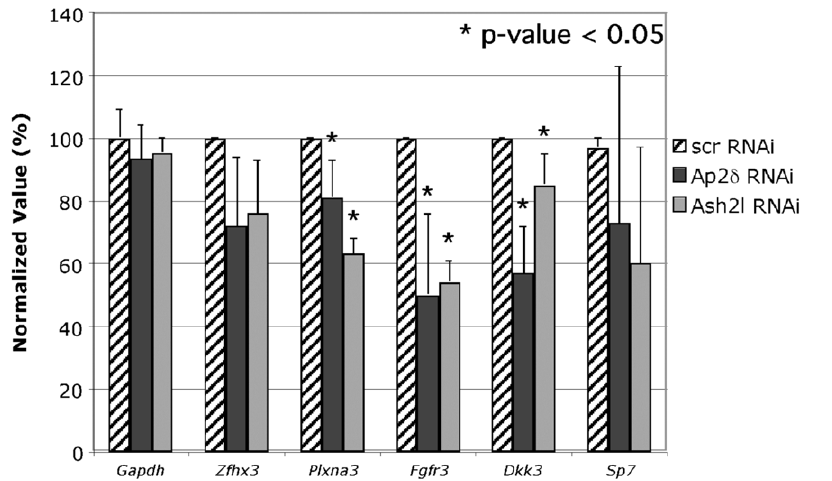
Figure 3. Ap2 d and Ash2l regulate Plxna3,Fgfr3andDkk3 expression in Neuro2a cells. Plxna3 , Fgfr3 and Dkk3 are downregulated when Ap2 d and Ash2l are downregulated. Total RNA was extracted 72 hours post-transfection from Neuro2a cells treated with Tcfap2d - or Ash2l -specific siRNA or scrambled control. Gapdh , Zfhx3, Plxna3, Fgfr3, Dkk3 and Sp7 transcript levels were quantified by real-time PCR. Normalized values were calculated as percentages of transcript levels detected in cells treated with the scrambled control. Significant differences are as indicated with * (p # .05). doi:10.1371/journal.pone.0008535.g003 PLoS ONE |